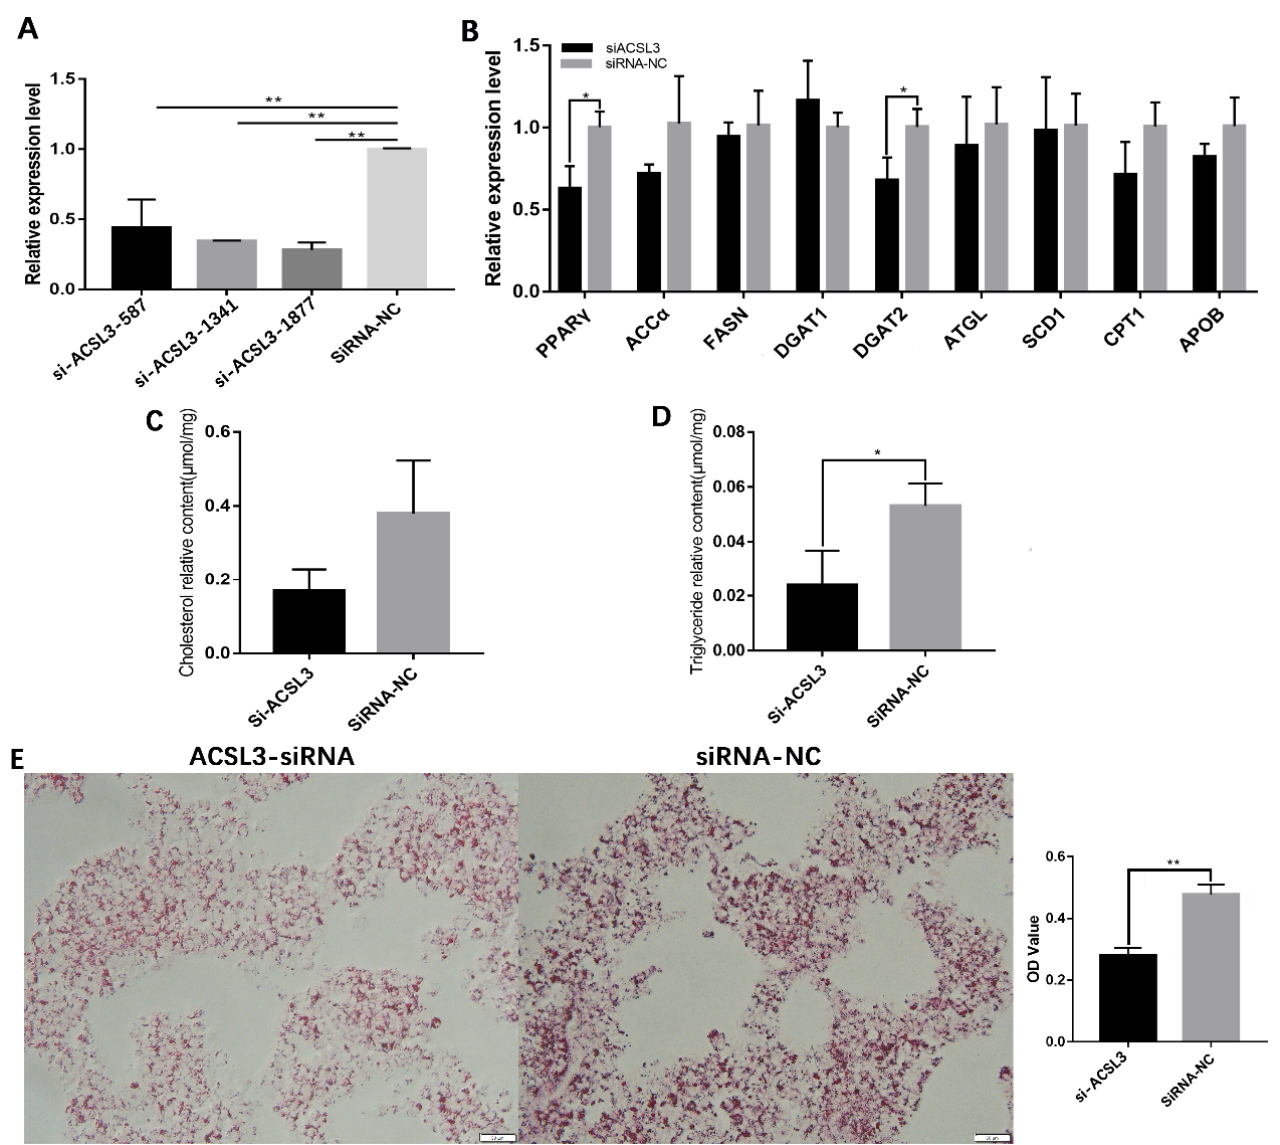
Figure 5. Downregulation of ACSL3 inhibits lipid deposition by goose GCs. ( A ) effect of ACSL3 siRNA on ACLS3 mRNA expression, ( B ) effects of interference of ACSL3 on the expression of genes related to lipid metabolism, ( C , D ) effect of si-ACSL3 on total TG and CH contents, and ( E ) effect of si-ACSL3 on lipid deposition in hGCs. * p < 0.05, ** p < 0.01. A qRT-PCR analysis of steroidogenesis-related genes showed that si-ACSL3-1877 significantly reduced StAR mRNA expression (Figure 6A); furthermore, analyses of extra- cellular E2 and P4 levels by ELISA revealed that the knock-down of ACSL3 also significantly inhibited the secretion of E2 (Figure 6B). These data indicate that ACSL3 promotes steroid hormone synthesis in